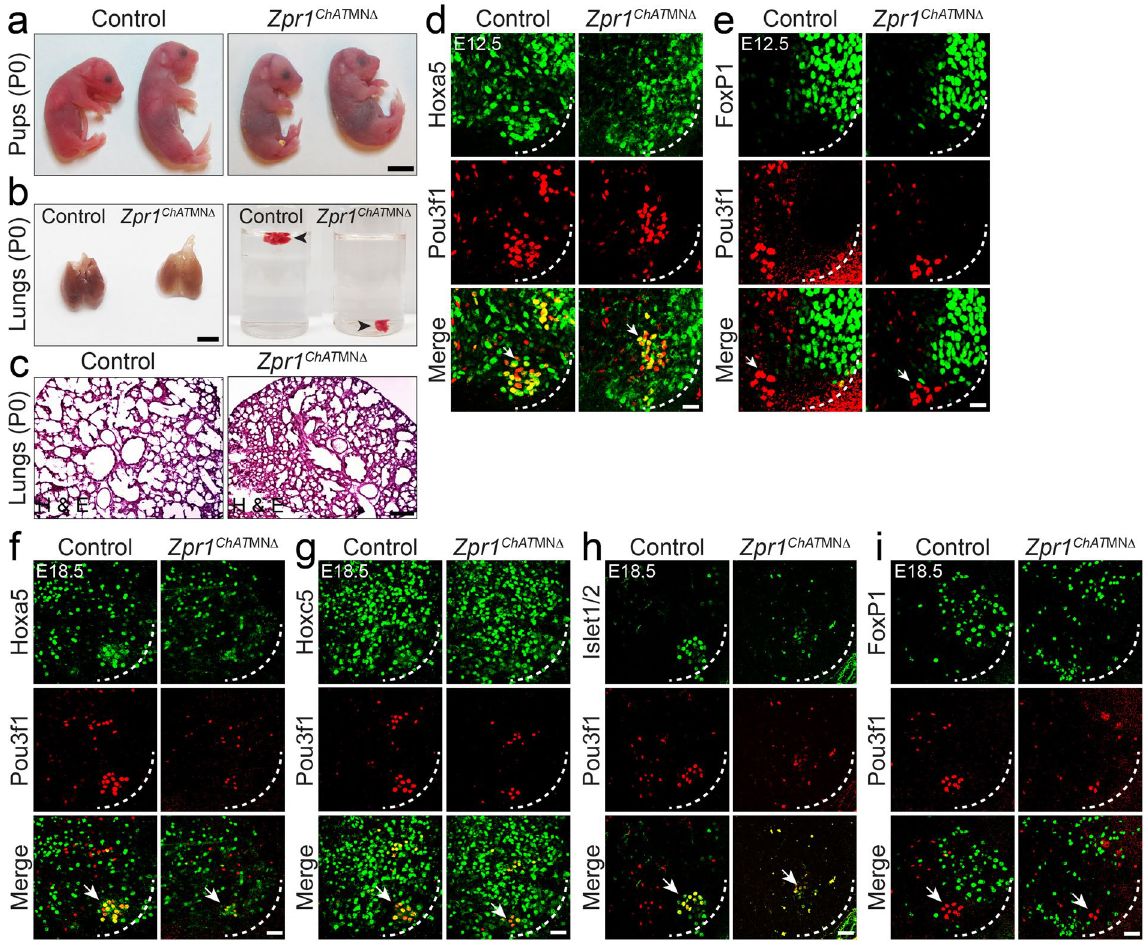
Figure 4. Temporal delay in mutation of Zpr1 preserves anatomical development but causes loss of PMC neurons and respiratory failure in Zpr1 ChAT MN Δ mice. ( a ) Photograph of control and Zpr1 ChAT MN Δ pups (P0) showing normal anatomical development. All mutant Zpr1 ChAT MN Δ mice (n > 20) were died immediately after birth. Scale bar is 5 mm. ( b ) Lungs from Zpr1 ChAT MN Δ pups (P0) were smaller than control and lungs of mutant embryos immediately sank in water, indicating lungs were not inflated with air suggesting mutant mice failed to breathe after birth. Scale bar is 3 mm. ( c ) Histological analysis shows defects in morphogenesis of lungs from Zpr1 ChAT MN Δ pups (P0) and lungs were underdeveloped. Scale bar is 200 μ m. ( d , e ) Spinal cord sections of the cervical region (C3-C5) from E12.5 control and Zpr1 ChAT MN Δ embryos were stained with antibodies against Pou3f1, Hoxa5 and FoxP1 proteins. Scale bar is 25 μ m ( d , e ). Quantification of Pou3f1 + , Hoxa5 + and FoxP1 + neurons (mean ± s.e.m.; n = 3 mice/group) at E12.5 stage is presented in Supplementary Figure S5a–c. ( f – i ) Spinal cord sections of the cervical region (C3-C5) from E18.5 control and Zpr1 ChAT MN Δ embryos were stained with antibodies against Pou3f1, Hoxa5, Hoxc5, Islet1/2 and FoxP1 proteins. Immunofluorescence images show that the delayed Zpr1 mutation causes loss of Pou3f1 + PMC motor neurons and disorganization of FoxP1 + LMC group of motor neurons. Quantification of Pou3f1 + , Hoxa5 + and Hoxc5 + neurons at E18.5 stage is presented in Supplementary Figure S5d–f. Quantification of neurons shows the loss of Pou3f1 + neurons (61.90 ± 12.59%, p = 0.0026), Hoxa5 + neurons (48.34 ± 12.67%, p = 0.0189) and Hoxc5 + neurons (12.97 ± 1.93%, p = 0.0027)